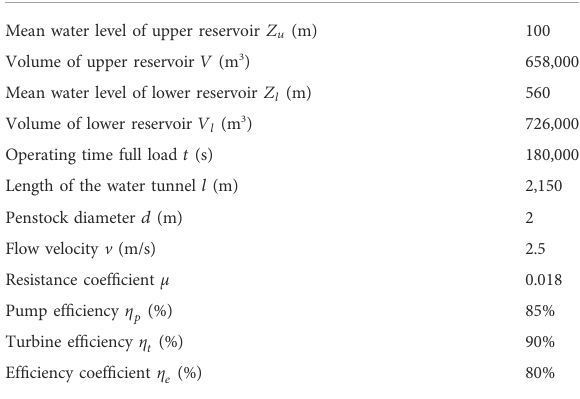
TABLE 1 Main characteristics of the